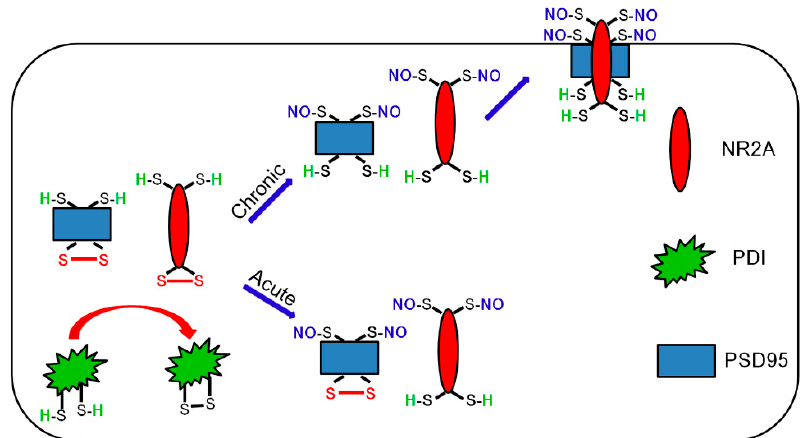
Figure 8. Schemes of the role of PDI in the seizure activity in acute and epilepsy model. PILO-induced acute seizure activity increases the bindings of PDI to NR2A, but not to PSD95, and total (free and SNO-) thiol level on NR2A. However, it decreases the NR2A binding to PSD95. Unlike acute seizure models, epileptic seizures increase PDI–PSD95 binding, total- and SNO-thiol levels on PSD95, and NR2A–PSD95 interaction. Since PDI siRNA e ff ectively inhibits spontaneous seizure activity, our findings suggest that PDI-mediated PSD95 redox may increase seizure susceptibility via facilitation of NR2A–PSD95 binding in epileptic animals, independent of S -nitrosylation of